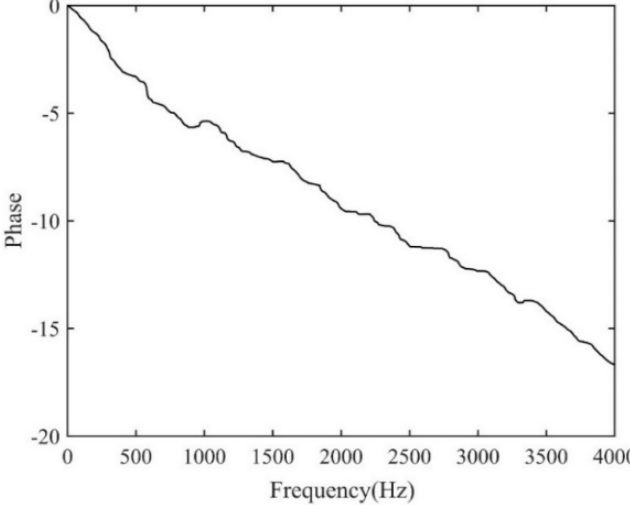
Figure 19. The new FRF between the signals measured at A1&A3.